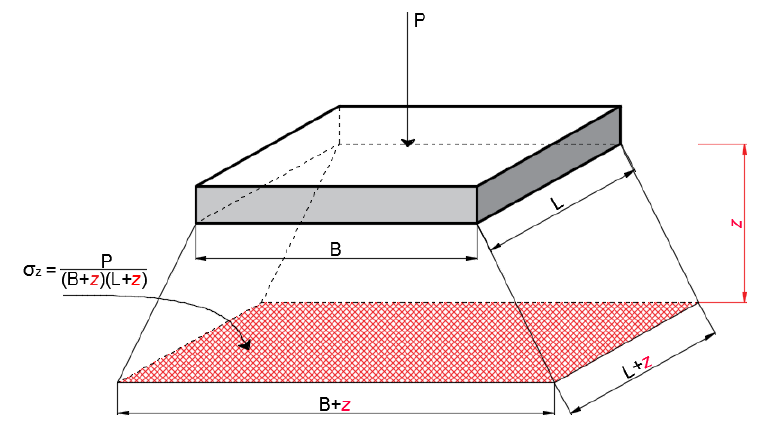
Figure A1. Schema of the approximate method for distribution of vertical stress due to surface load.